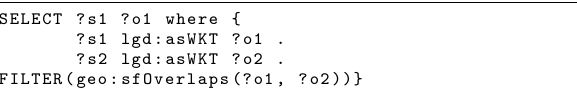
Figure 11. Example of a spatial selection query